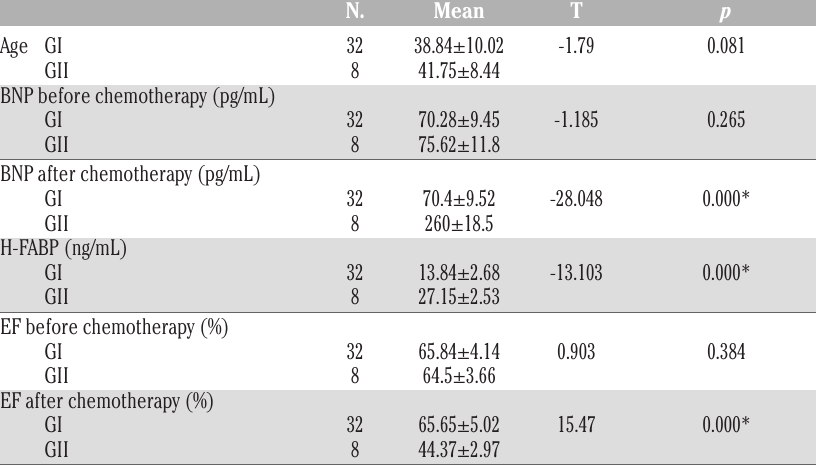
Table 2. Comparison between group I and II patients as regards BNP and H-FABP.